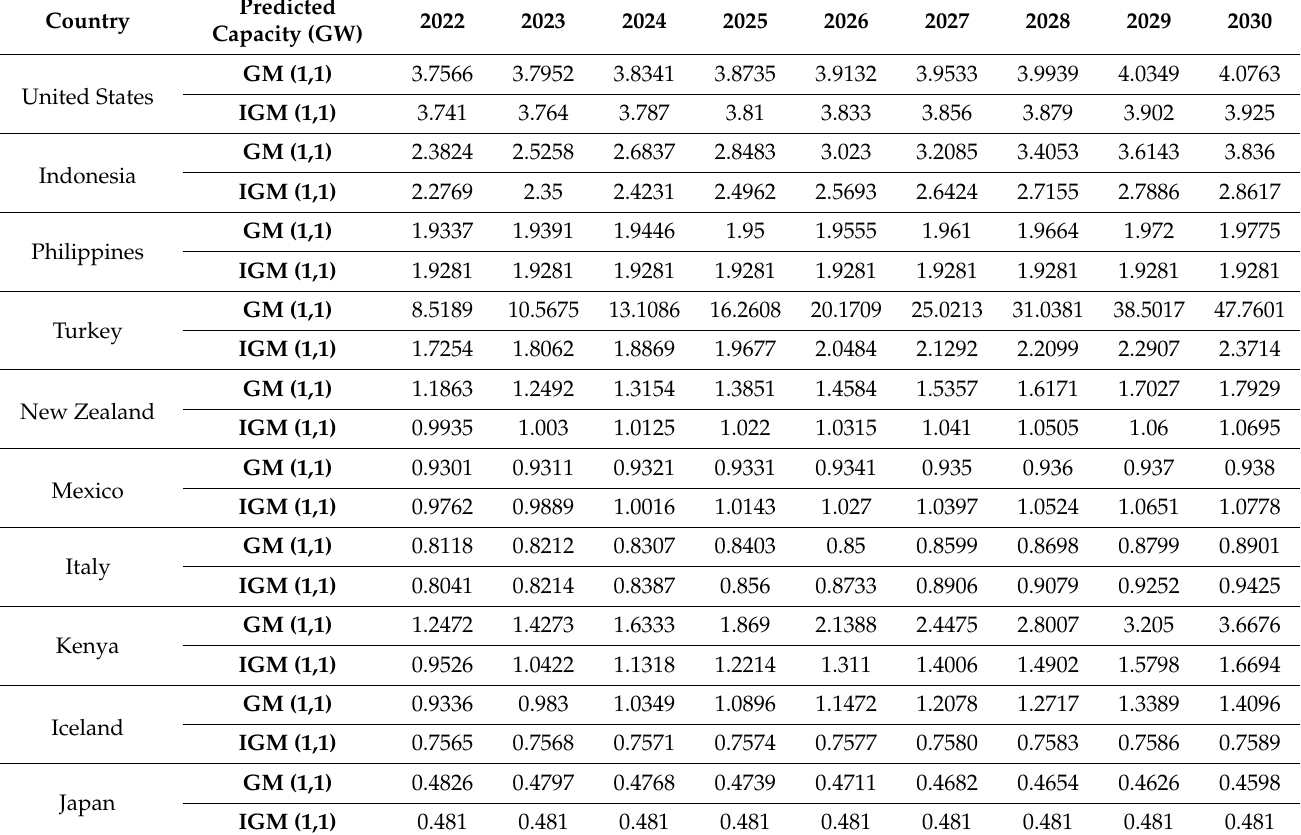
Figure 3. Actual (in-sample) and predicted (out-of-sample) geothermal energy installation capacity values for ( a ) the United States, ( b ) Indonesia, ( c ) Turkey, ( d ) the Philippines, ( e ) New Zealand, ( f ) Mexico, ( g ) Italy, ( h ) Kenya, ( i ) Iceland, and ( j ) Japan.